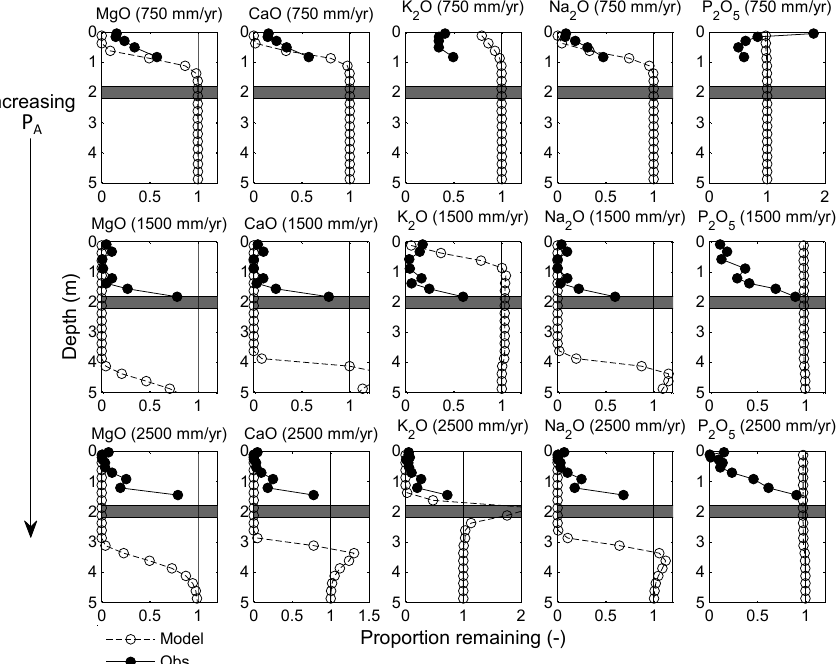
Figure 10. Observed vs. simulated oxide losses/gains across a mean annual precipitation gradient ( P A ) on the 350ka Pololu lava flow. Values < 1 indicate a loss relative to the parent material, and values > 1 indicate relative accumulation. The grey box shows the location of the pahoehoe